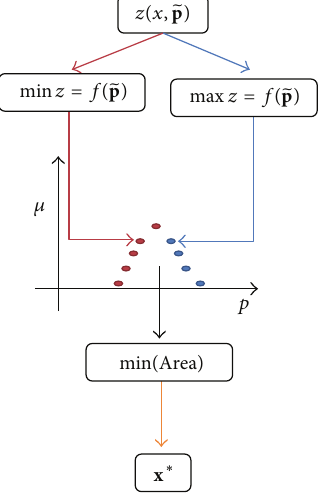
Figure 5: Flowchart for the fuzzy response minimization procedure.